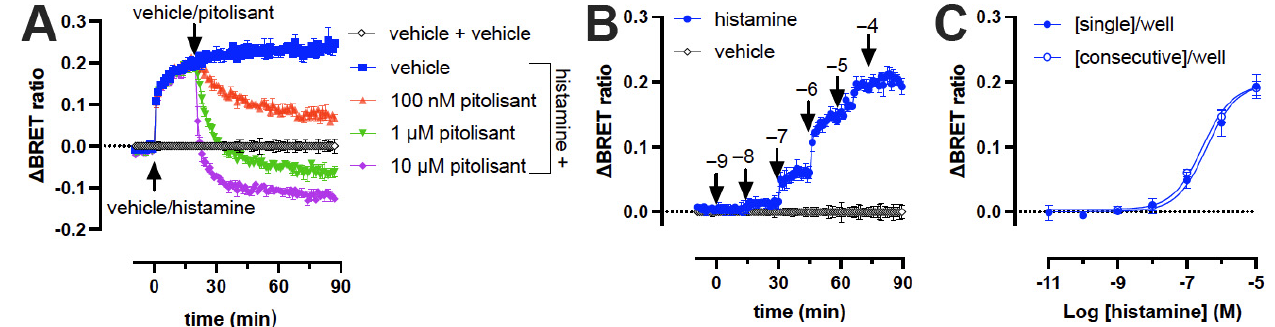
Figure 2. Dynamic changes in ∆ icl3-H 3 R Nluc/Halo(618) biosensor conformation detected by BRET in intact HEK293A cells. ( A ) Injection of different concentrations pitolisant attenuates the histamine-induced (10 µ M) conformational change in the H 3 R biosensor. ( B ) Consecutive injection of increasing (log) concentrations of histamine in the same three wells. Data are displayed as mean ± SD from one representative experiment performed in triplicate. ( C ) Concentration-response curve of histamine generated from Figure 2B, 15 min after each consecutive injection of increasing concentrations histamine in triplicate (3 wells/exp) or 15 min after stimulation of individual wells with increasing concentrations histamine in triplicate (21 wells/exp). Data are displayed as mean ± SD from 3 independent experiments performed in triplicate.